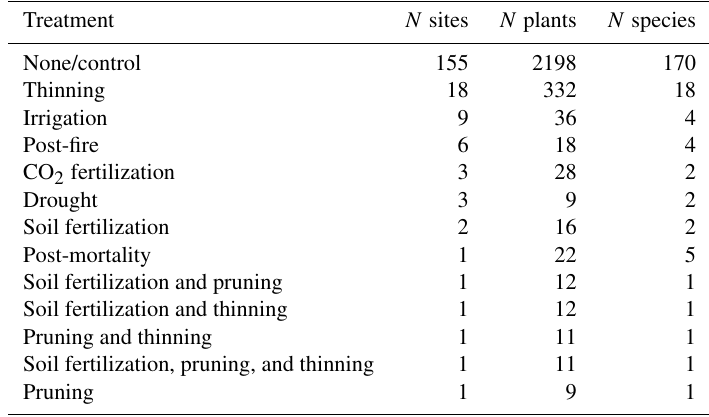
Table 3. Number of datasets, plants, and species by stand-level treatment in the SAPFLUXNET database. Treatment N sites N plants N species None/control 155 2198 170 Thinning 18 332 18 Irrigation 9 36 4 Post-fire 6 18 4 CO 2 fertilization 3 28 2 Drought 3 9 2 Soil fertilization 2 16 2 Post-mortality 1 22 5 Soil fertilization and pruning 1 12 1 Soil fertilization and thinning 1 12 1 Pruning and thinning 1 11 1 Soil fertilization, pruning, and thinning 1 11 1 Pruning